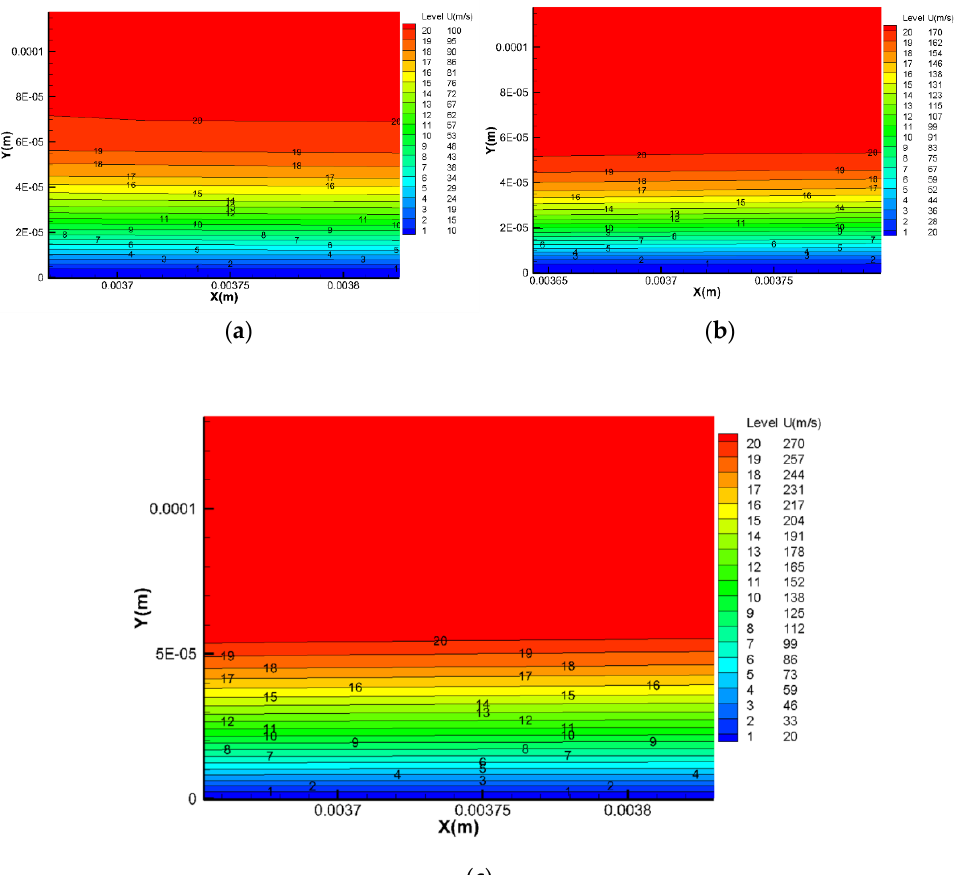
Figure 13. Near-wall velocity cloud picture of smooth plate under different Mach numbers; ( a ) 0.3 Ma;